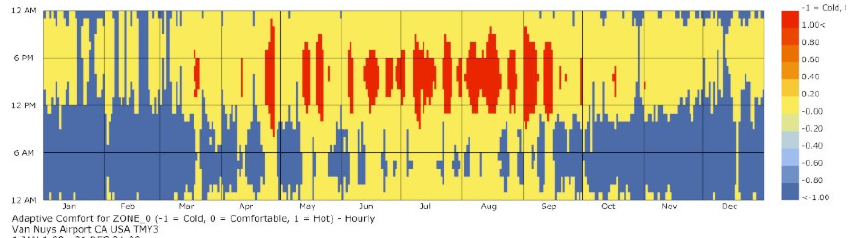
Figure 12. Graph of Daylight Comfort Simulation.